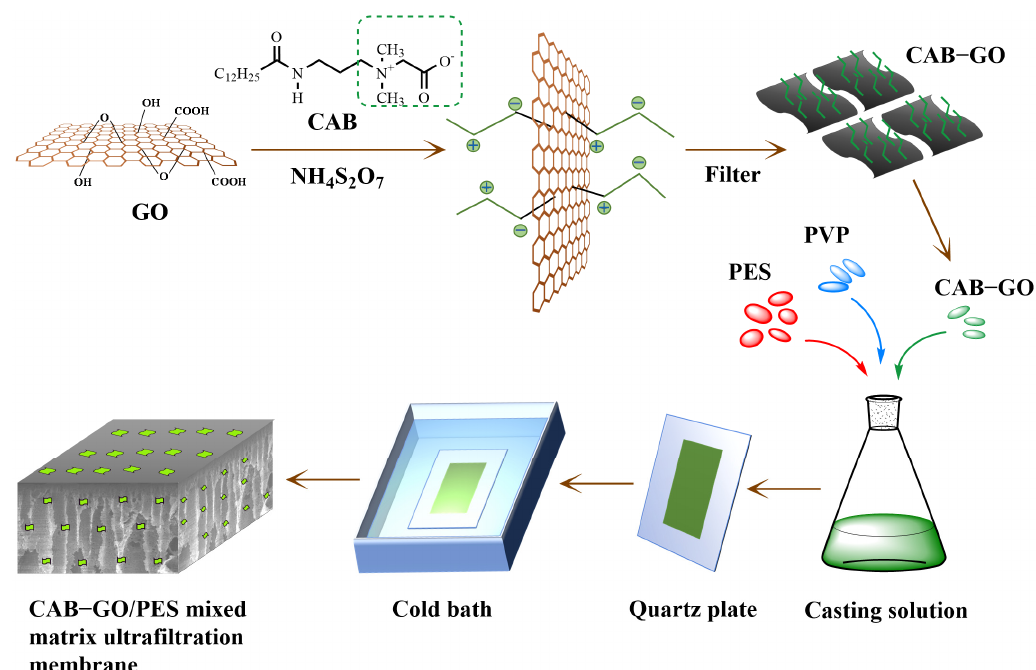
Figure 1. Scheme of the preparation process of a CAB − GO/PES membrane.